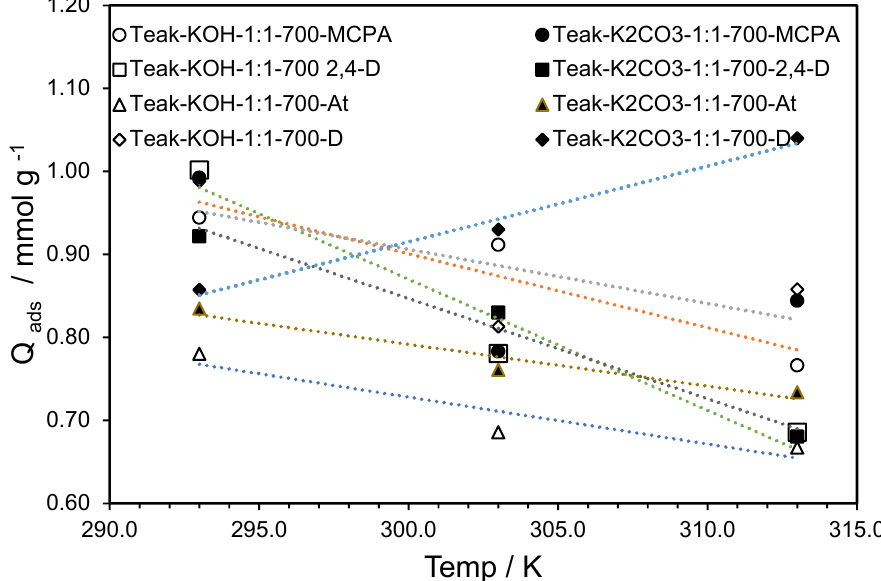
Figure 4. Temperature influence on the maximum adsorption capacity of Teak-KOH-1-1-700 and Teak-H 2 CO 3 -1-1-700, for the four pesticides.